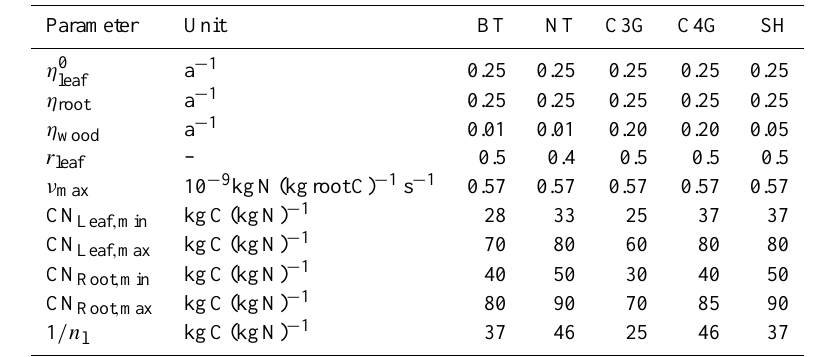
Table 2. List of PFT-dependent parameters used in UVic-CN: leaf base turnover rate ( η 0 ), root turnover rate ( η root ) and wood turnover leaf rate ( η wood ) are all taken from the UVic ESCM. r leaf is the PFT-dependent retranslocation of N before leaf abscission and ν max is the tuned maximum N uptake rate. Minimum and maximum C/N ratios for leaves (CN Leaf , min , CN Leaf , max ) and roots (CN Root , min ,CN Root , max ) for each PFT are chosen as follows: CN Leaf , min are the inverted maximum leaf N concentrations used in the previous UVic ESCM (Meissner et al., 2003) with the exception of the value for C3G which is raised from 18 to 25. CN Leaf , max are allocated in order to allow a wide range of possible C/N ratios, CN Root , min and CN Root , max are set to be higher than CN Leaf , min and CN Leaf , max (White et al., 2000). Average leaf nitrogen concentration, n l , is used in the C-only version to calculate Rubisco activity V c , max . BT = broad-leaved trees, NT = needle-leaved trees, C3G = C 3 grasses, C4G = C 4 grasses, SH = shrubs.